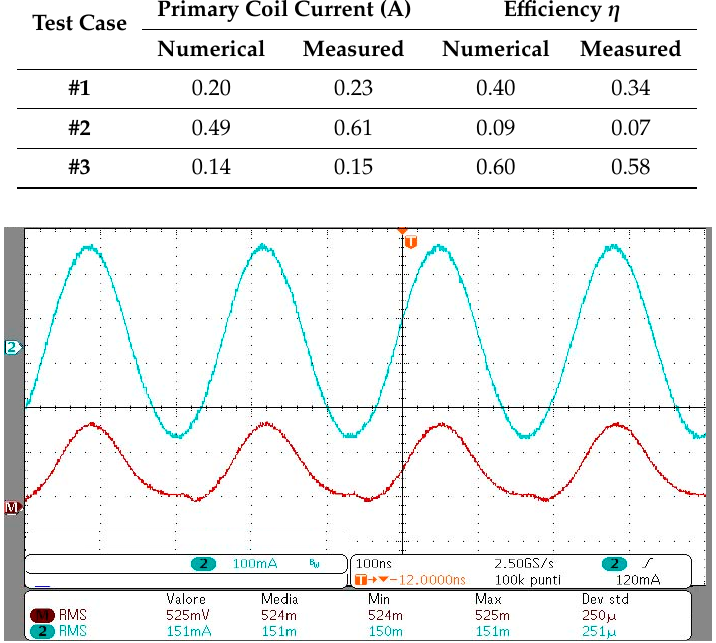
Figure 19. Measured output voltage V out . Figure 20. Output power P out vs. inclination angle θ . P ou t ( W )